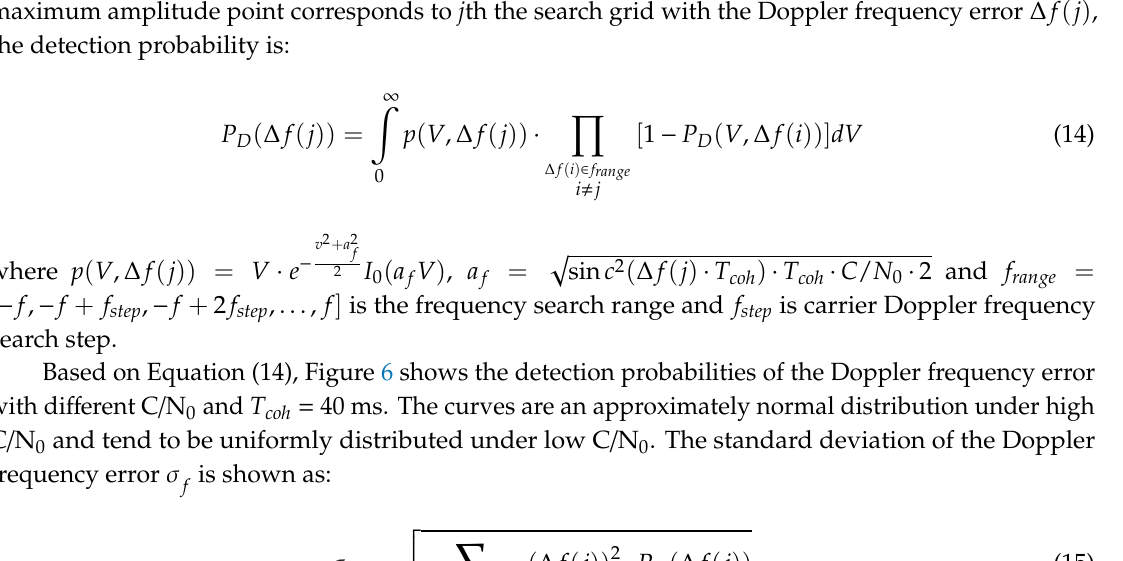
Figure 5. Code error of the open loop under thermal noise.